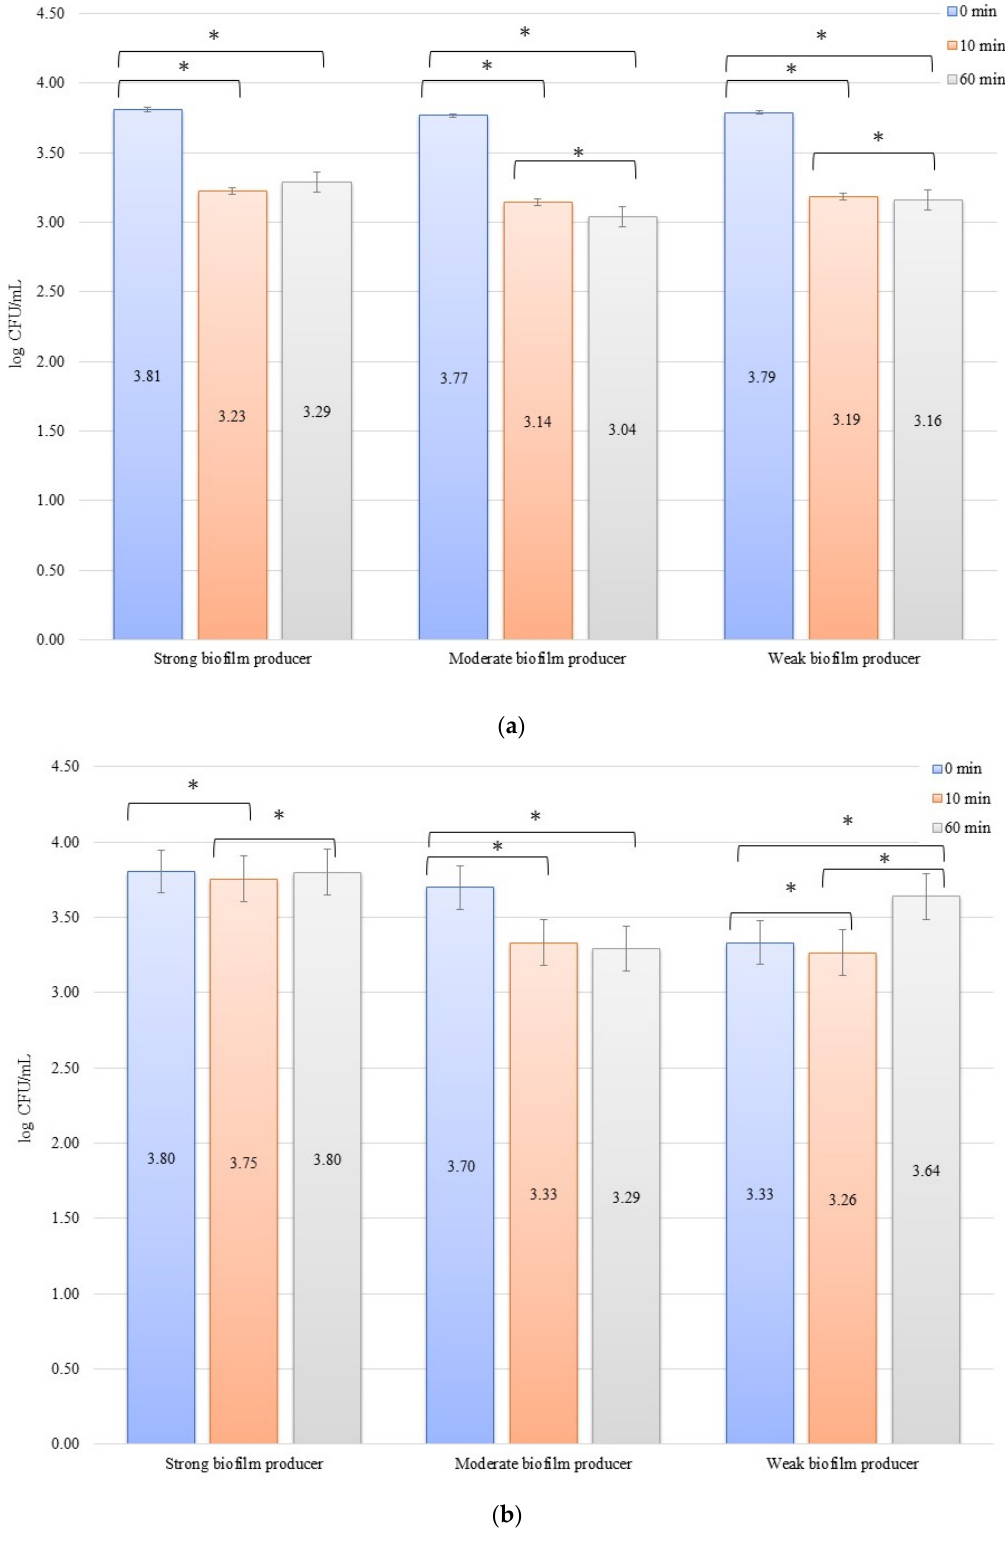
Figure 3. Biofilm eradication assay for Staphylococcus aureus . Strains forming biofilms on Ti-6Al-4V ( a ) and zirconium dioxide ( b ) discs classified as strong, moderate, weak, and non-producers are treated using low direct electric currents of 1 mA. Error bars represent the pooled standard deviations of the mean. The level of significance is presented at * p < 0.05. The mean and standard deviation are shown.